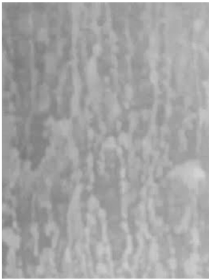
Figure 8. Drop distribution over the test specimen of the laboratory irrigation.